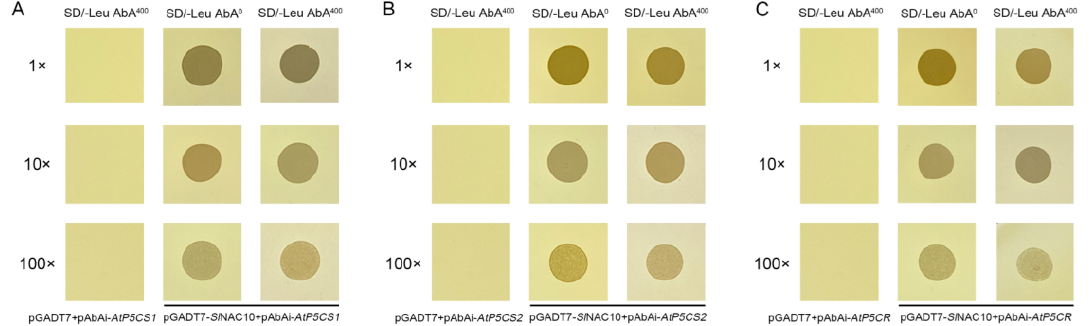
Figure 9. Sl NAC10 transcription factor binds to synthesis-related enzyme gene promoters. Sl NAC10 transcription factor binds to ( A ) AtP5CS1 promoter, ( B ) AtP5CS2 promoter, ( C ) AtP5CR promoter .